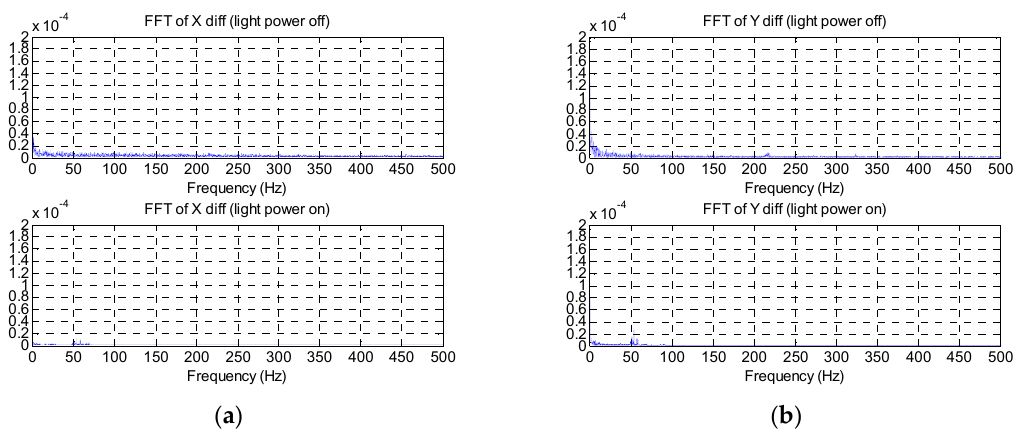
Figure 14. Power on/off of Blu − ray to observe the PSD output signals. ( a ) PSD output signals for the X − orientation; ( b ) PSD output signals for the Y − orientation.